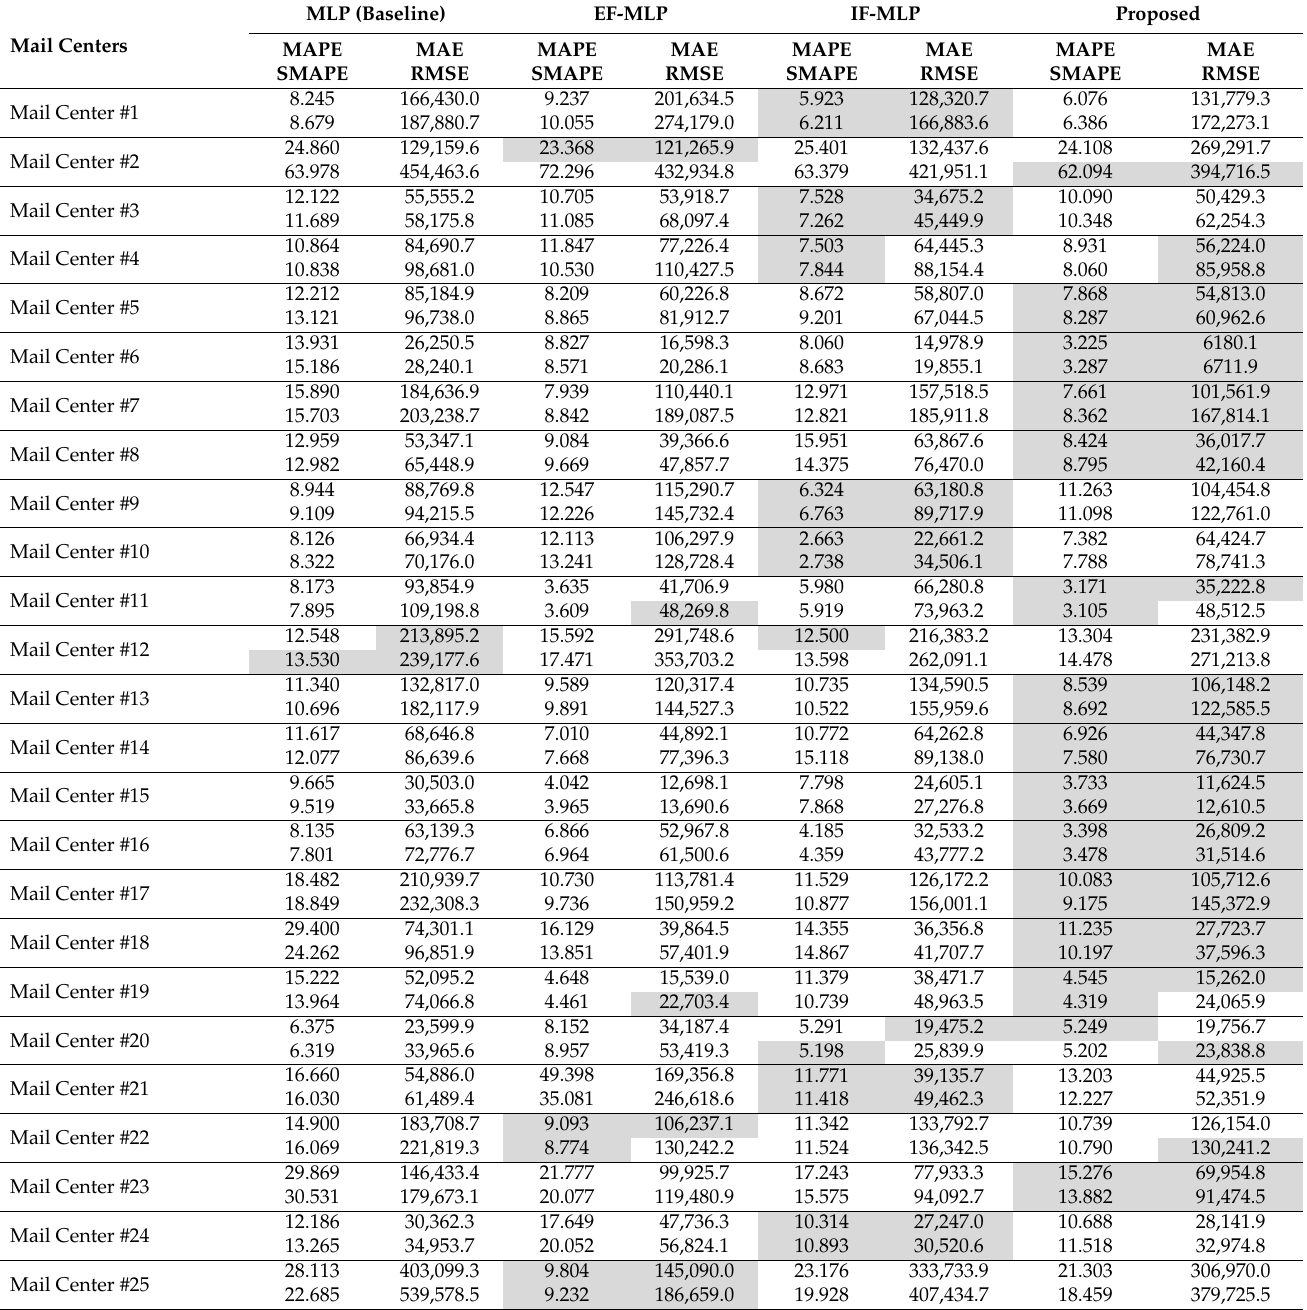
Table 2. Performance of MLP models by the proposed method on the 25 mail center